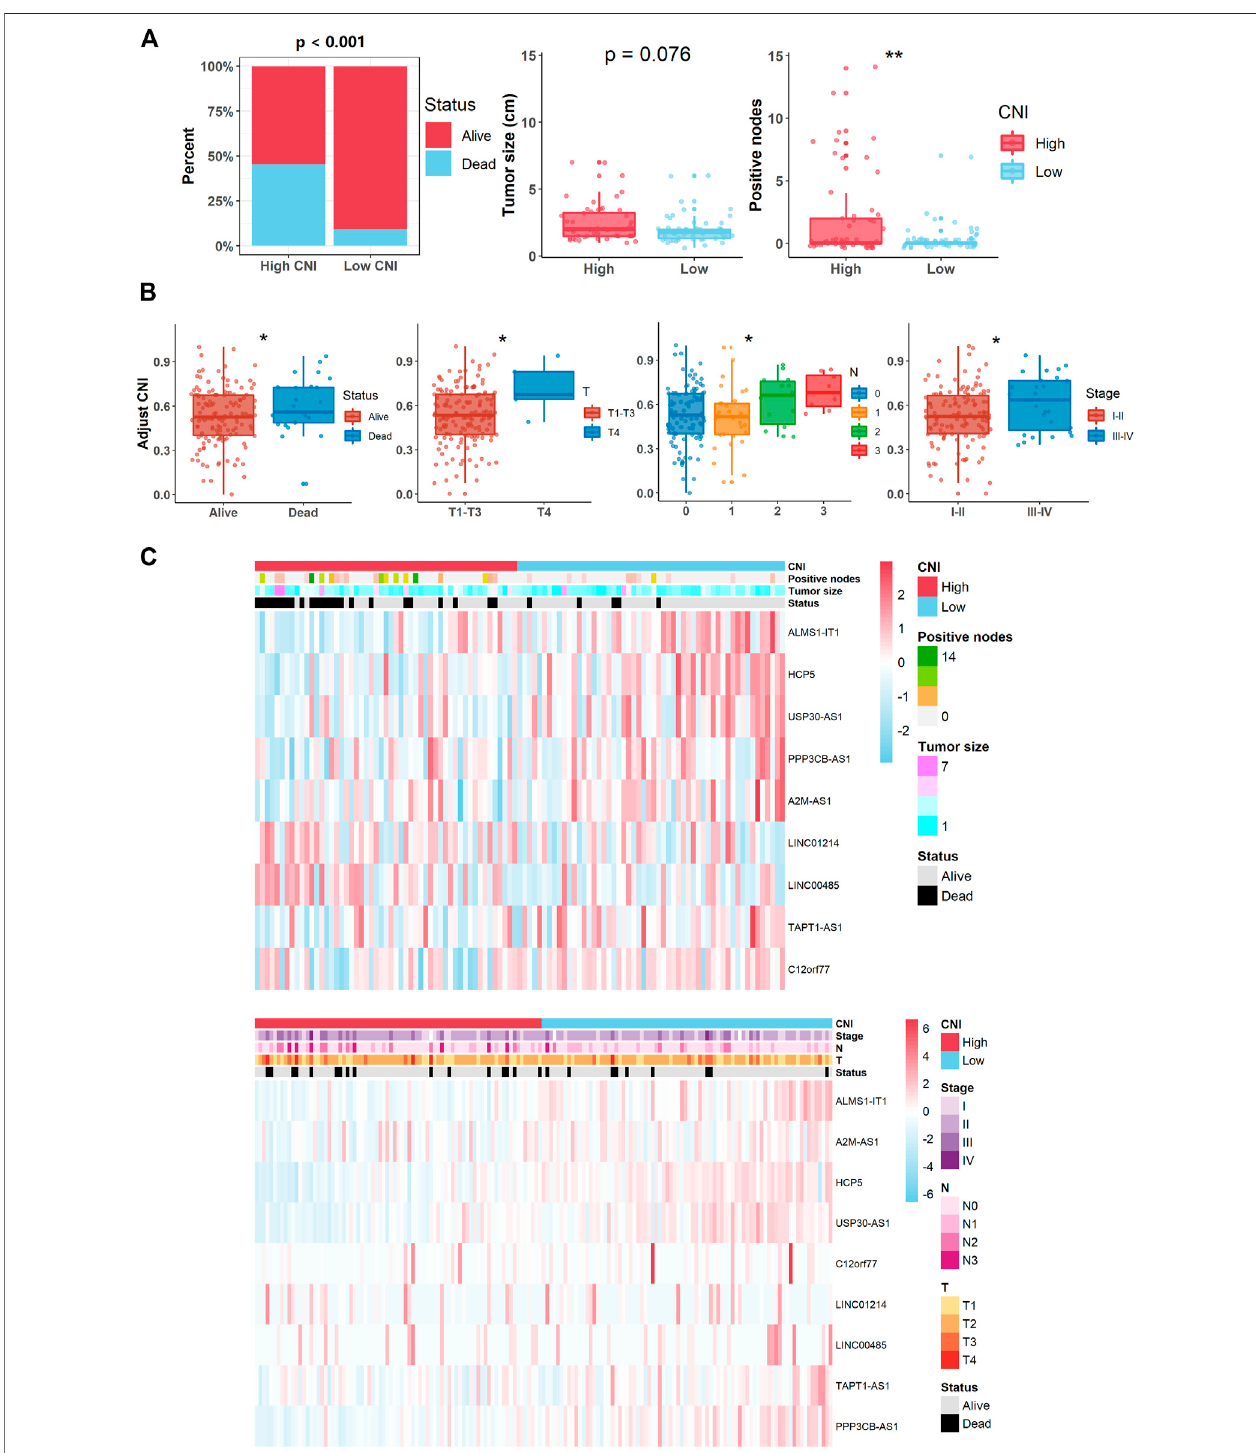
FIGURE 5 | Relationship between the CNI value and clinical features (** and * indicate p < 0.01 and < 0.05, respectively). (A) Patients with different clinicopathological features (such as survival status, tumor size, and lymph node metastasis) had different levels of CNI values in the training cohort. (B) Patients with variousclinicopathologicalfeatures(suchassurvivalstatus,Tstage,Nstage,andAJCCstage)haddifferentlevelsofCNIvaluesinthevalidationcohort. (C) Heatmapsof the associationsbetweenthe expression levels ofthe nine necroptosis-related lncRNAs and CNI and clinicopathological features(upper plot forthe training cohort and lower plot for the validation